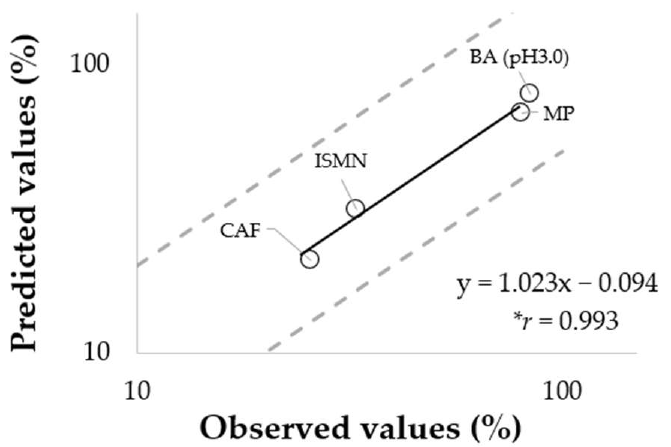
Figure 6. Comparison of predicted values using Strat-M ® versus observed values using porcine skin for percutaneous absorption ratio. Each point represents the mean, while dashed lines correspond to a factor 2. The Pearson’s correlation coefficient showed statistical significance (* p < 0.05).